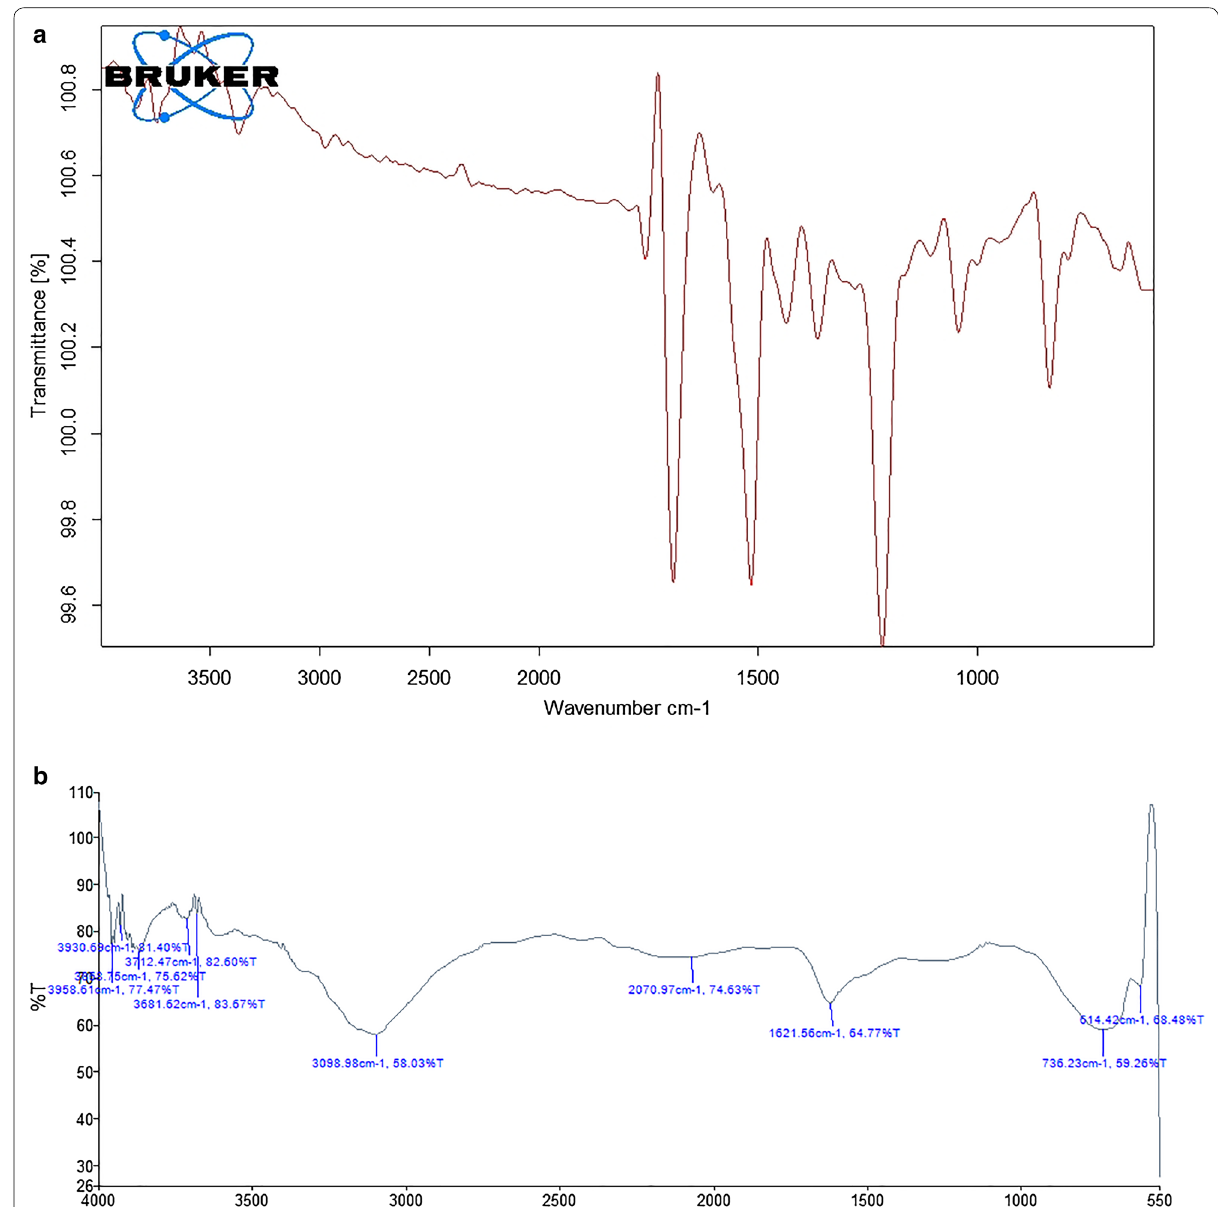
Fig. 5 Analysis of chemical bonds produced during APAP degradation by Bacillus drentensis strain S1 by FTIR: a control sample FTIR of APAP; b FTIR of sample after degradation of